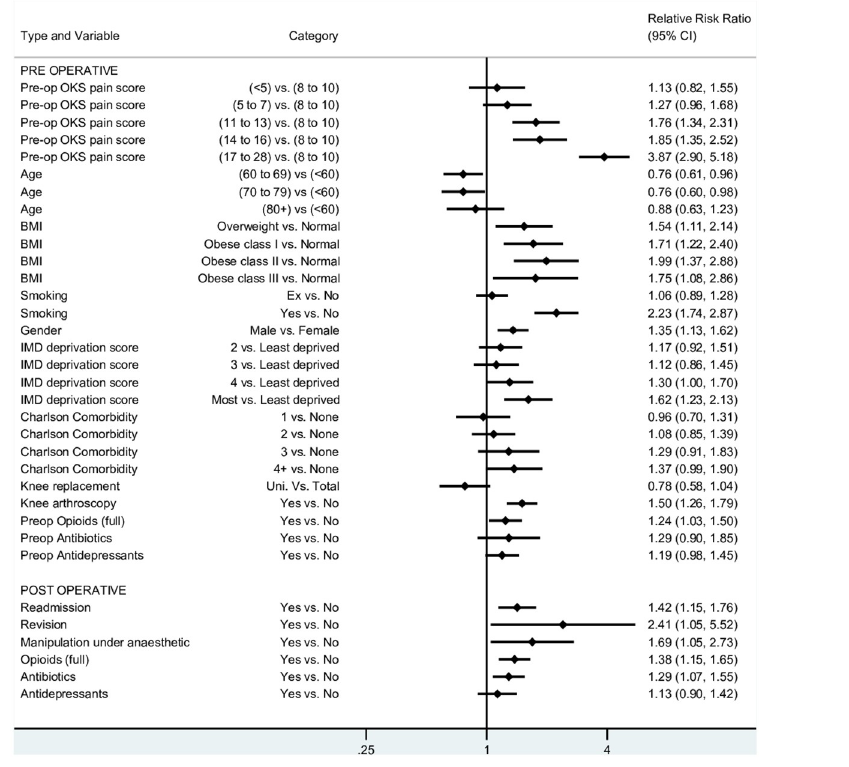
Fig 3. Forest plot of predictors of poor pain